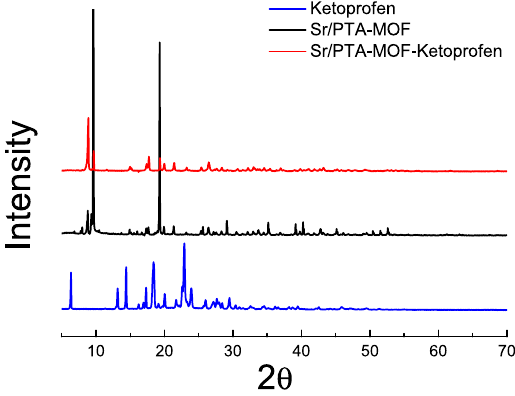
Figure 1. XRD analysis of Sr/PTA-MOF before and after loading ketoprofen.